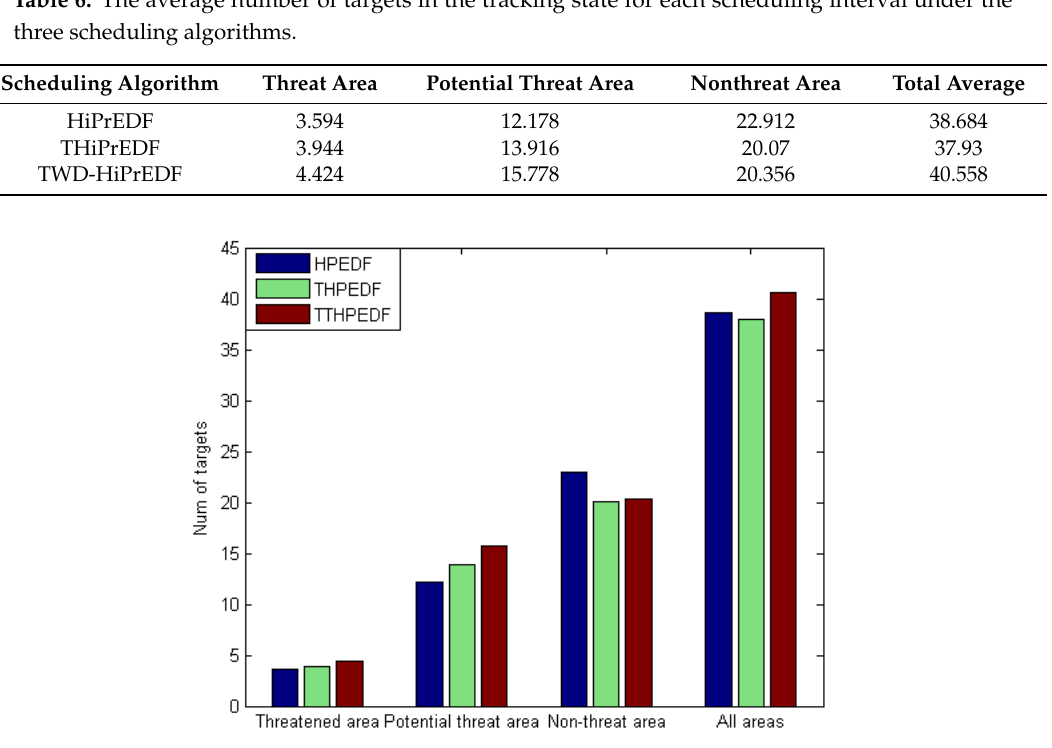
Table 6. The average number of targets in the tracking state for each scheduling interval under the three scheduling algorithms.